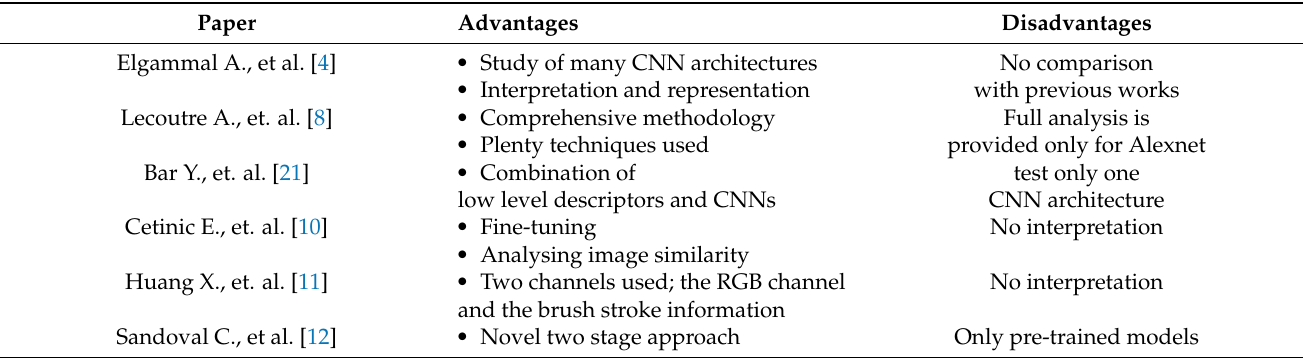
Table 1. Artwork style recognition based on DL